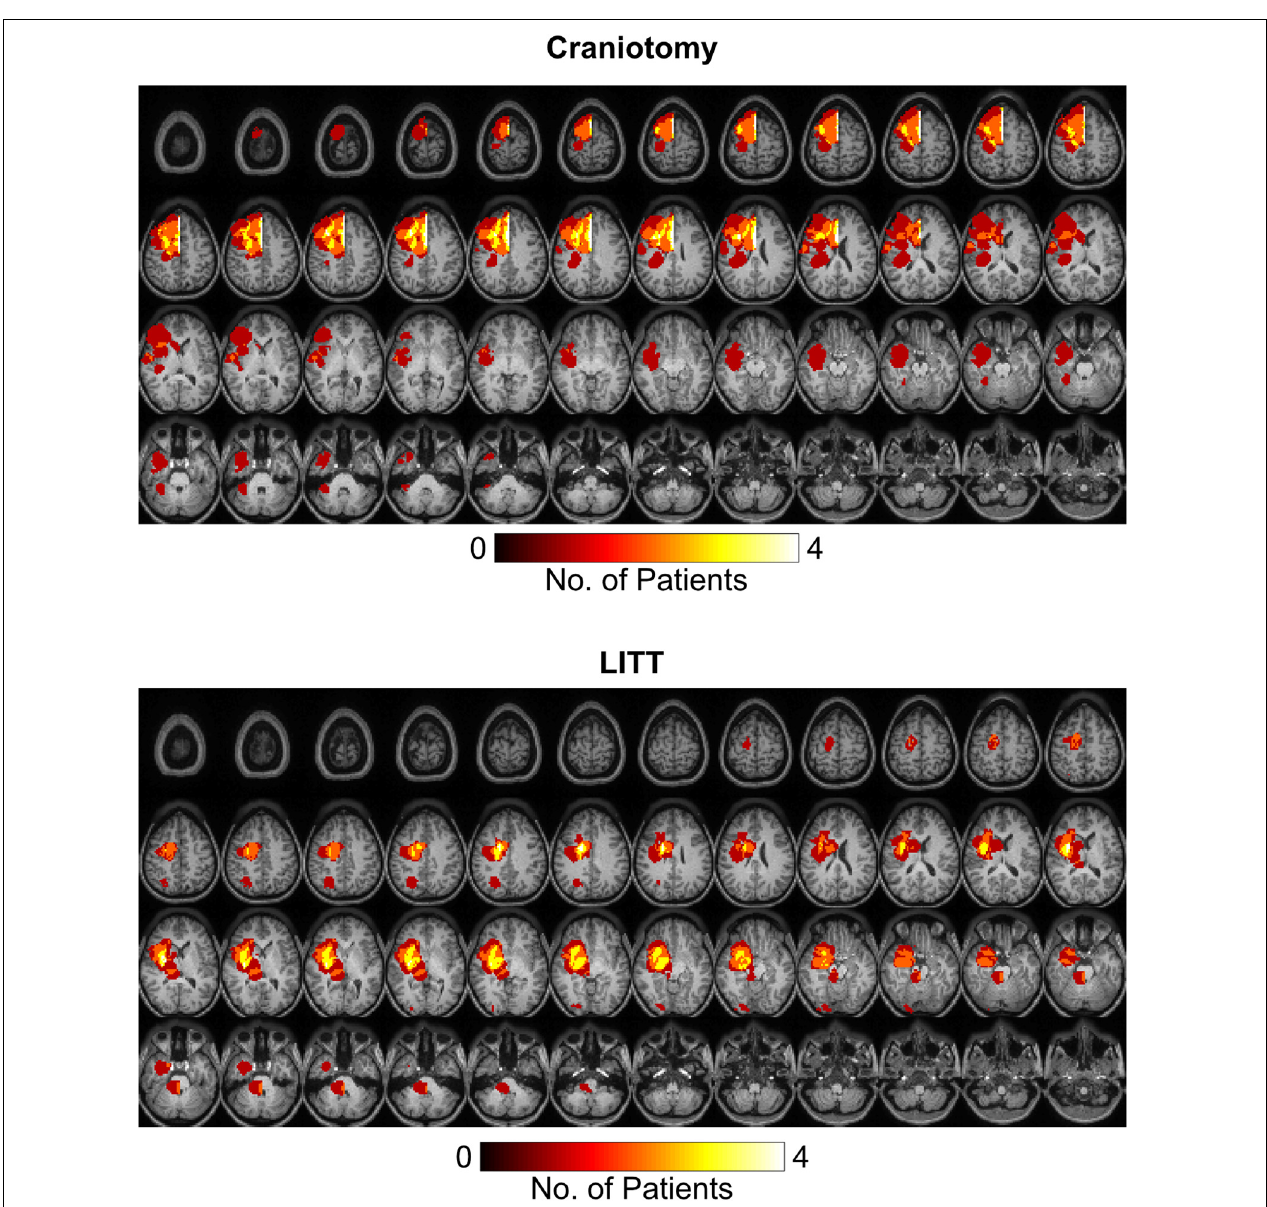
FIGURE 2 | Heat maps representing tumor locations in the craniotomy and LITT (laser interstitial thermal therapy) treatment groups. All tumors were mapped to the right hemisphere for a clearer illustration of tumor location. T1-weighted post-contrast images were used for tumors with contrast enhancement while FLAIR (fluid attenuated inversion recovery) hyperintensity was used for tumors without contrast